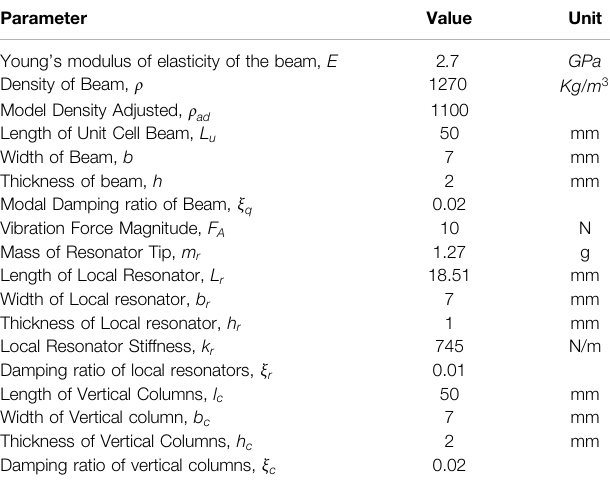
TABLE 1 | Design parameters of the layered metamaterial structure. Parameter Value Young ’ s modulus of elasticity of the beam, E